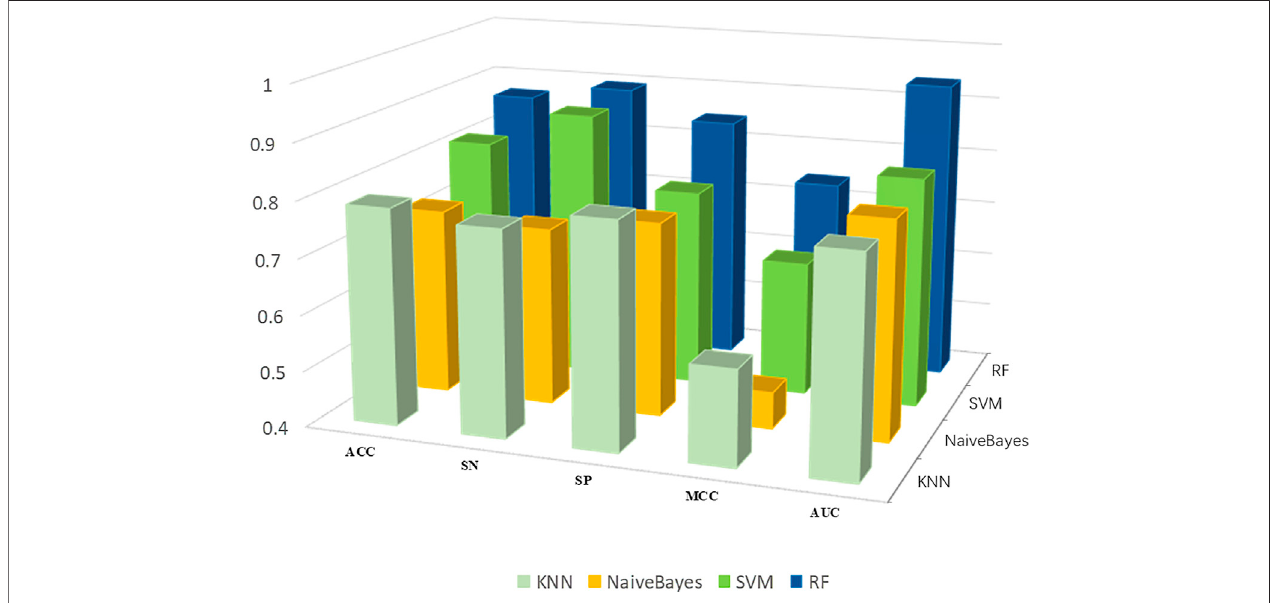
FIGURE 4 | Performance of training set PDB1075 on different classi fi ers.